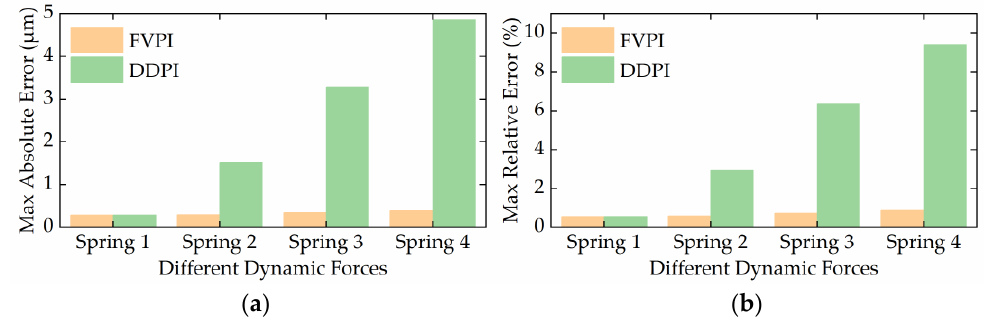
Figure 10. Two model error evaluation at different dynamic forces: ( a ) MAE; ( b ) MRE.